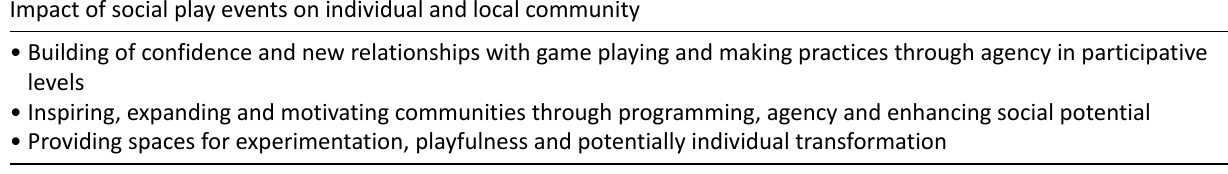
Table 4. An overview of the impact of social play events locally and more widely as described by the model of participation. Impact of social play events on individual and local